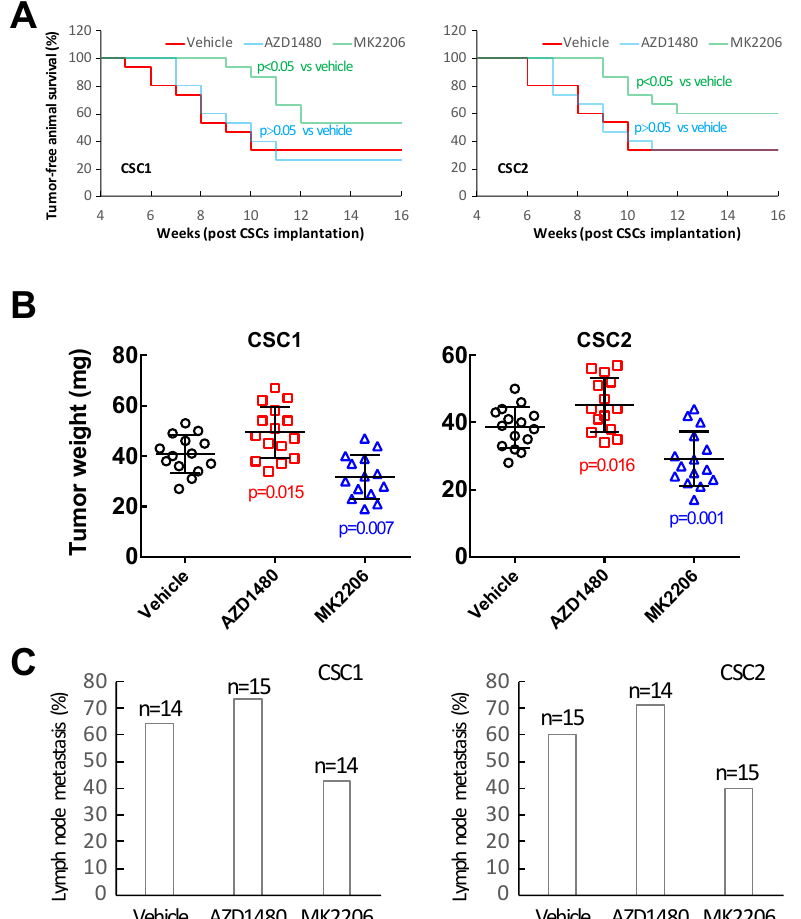
( B ) The effects of PI3K/Akt and JAK/STAT3 signaling blockade on CSC invasive activity were reproducible in a different patient-derived CSCs. ( C ) Quantitative analyses showed significant effects of PI3K/Akt signaling blockade on the enhanced CSC invasion. The JAK/STAT3 signaling blockade did not significantly affect the enhancement of CSC invasion. ( D ) Blocking PI3K/Akt signaling decreased the pAkt expression compared with the vehicle and the blockade of JAK/STAT3 signaling (left panel). Blocking JAK/STAT3 signaling decreased the pStat3 expression compared with the vehicle and the blockade of PI3K/Akt signaling (right panel). ** p < 0.01; ns, not significant. Scale bars: 100 µ m.